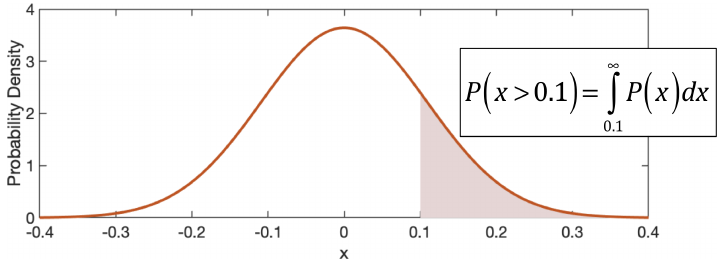
Figure A3. Calculating probabilities using